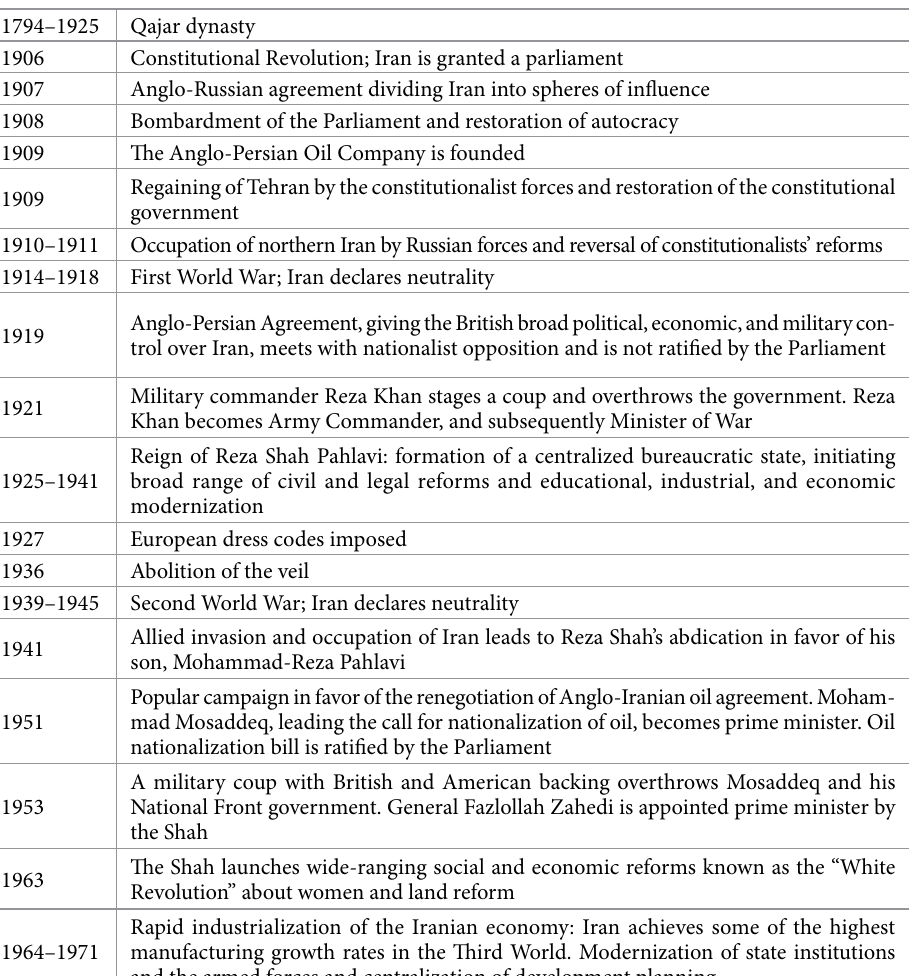
Table 2. Contemporary Iran political background (Gheissari, Nasr